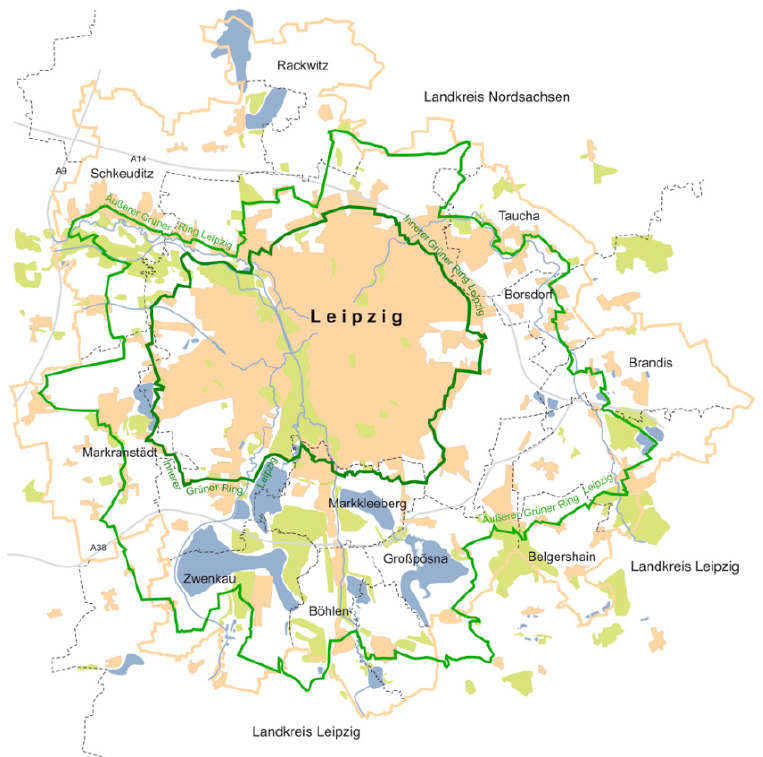
Figure 5. Green belt of Leipzig (dark green = ‘Inner Green Belt’; light green = ‘Outer Green Belt’). Source: Administrative Office of Green Ring Leipzig—https://gruenerring-leipzig.de/wp-content/uploads/2017/06/grünerring-kurzinhalt2.pdf.